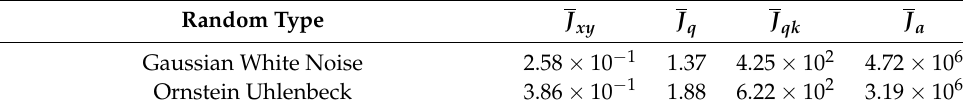
Table 7. Comparison of quality indicators depending on the type of random.